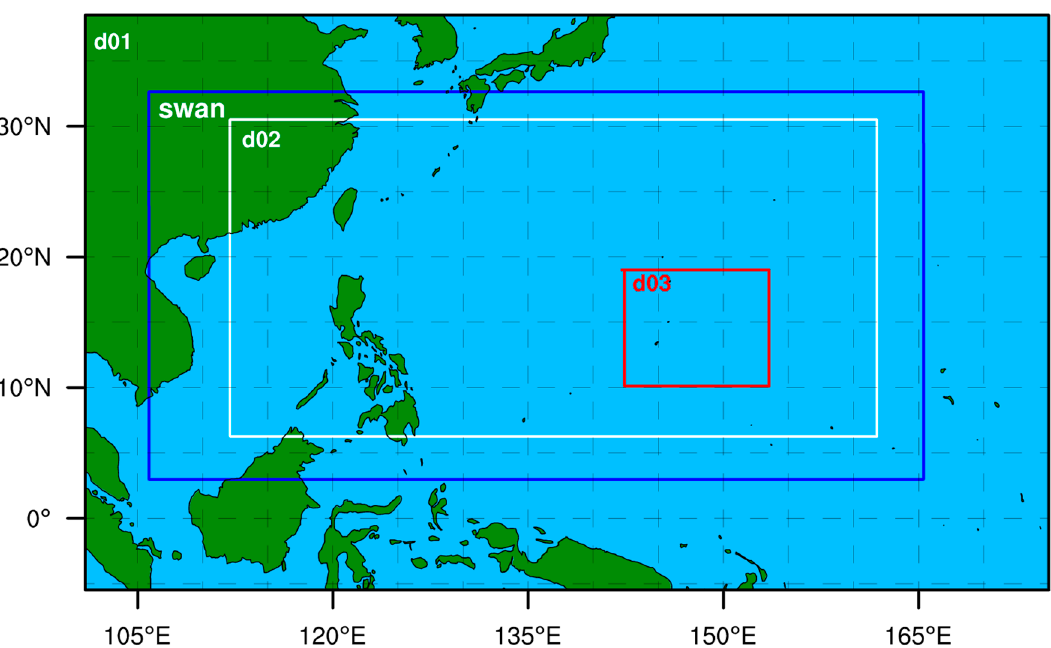
Figure 1. Model domains in the simulation of TC Mangkhut. the outermost box is d01, d02 is the white box, and the red box represents d03. The blue box represents the domain of SWAN.